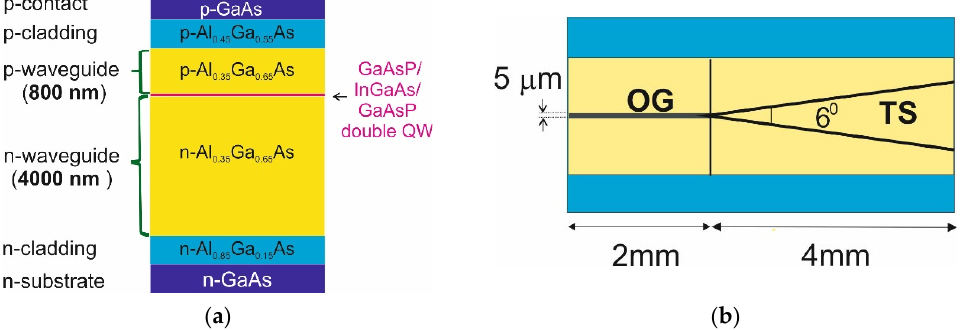
Figure 2. Epitaxial layer structure ( a ) and top view ( b ) of the power amplifier with integrated optical gate (OG) and tapered section (TS). gate (OG) and tapered section (TS).